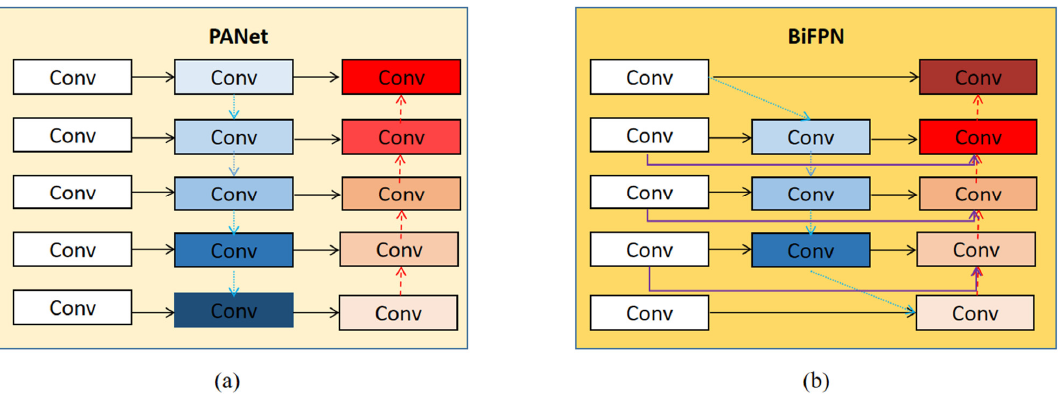
Figure 3. Comparison of BiFPN and PANet network structures [35,51]. ( a ) is the PANet network structure, and ( b ) is the BiFPN network structure, where conv is convolution node.